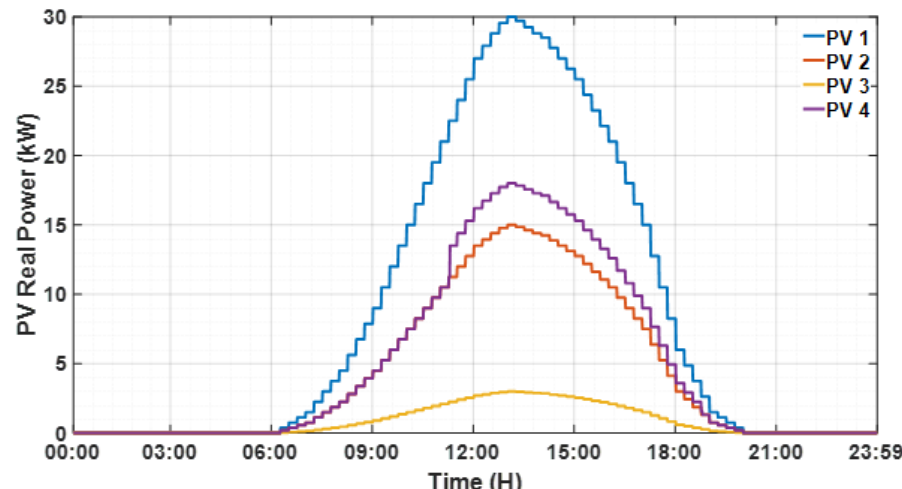
Figure 15. Real power output of